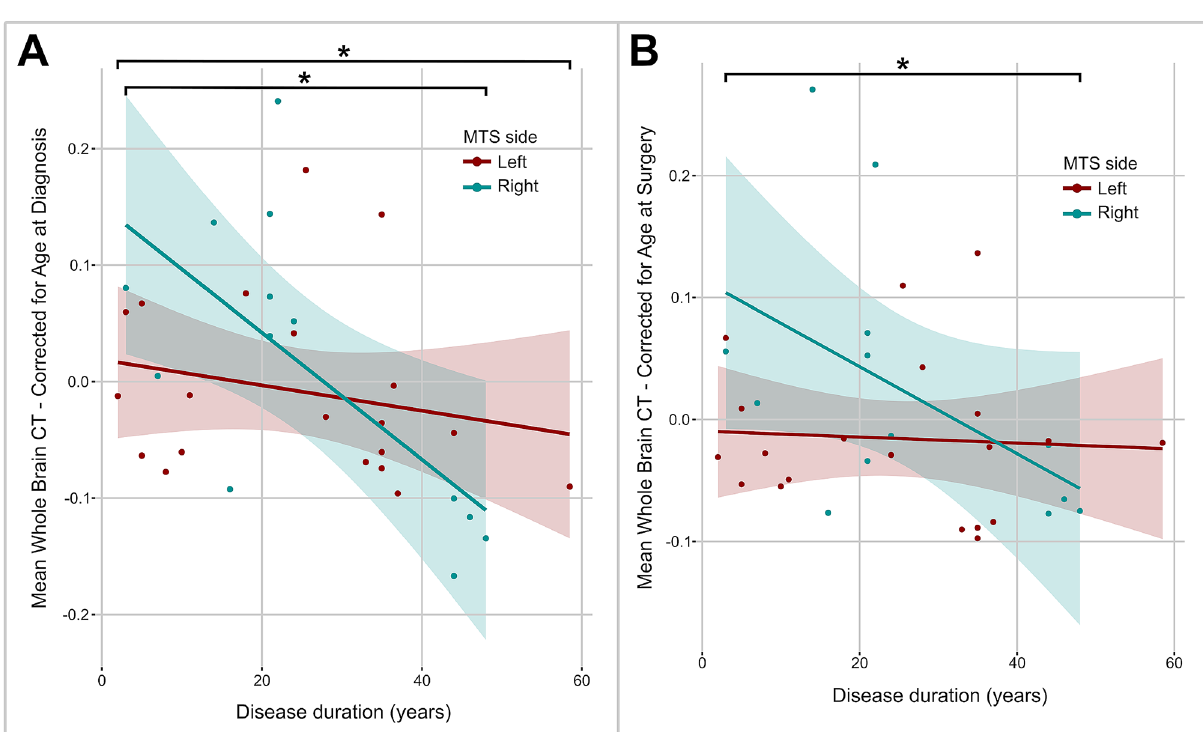
Figure 2. Whole brain cortical thickness decrease is related to disease duration and seizure focus laterality. ( A ) The relationship between disease duration and whole brain cortical thickness after correcting for age at diagnosis. ( B ) Relationship between disease duration and whole brain cortical thickness after correcting for age at